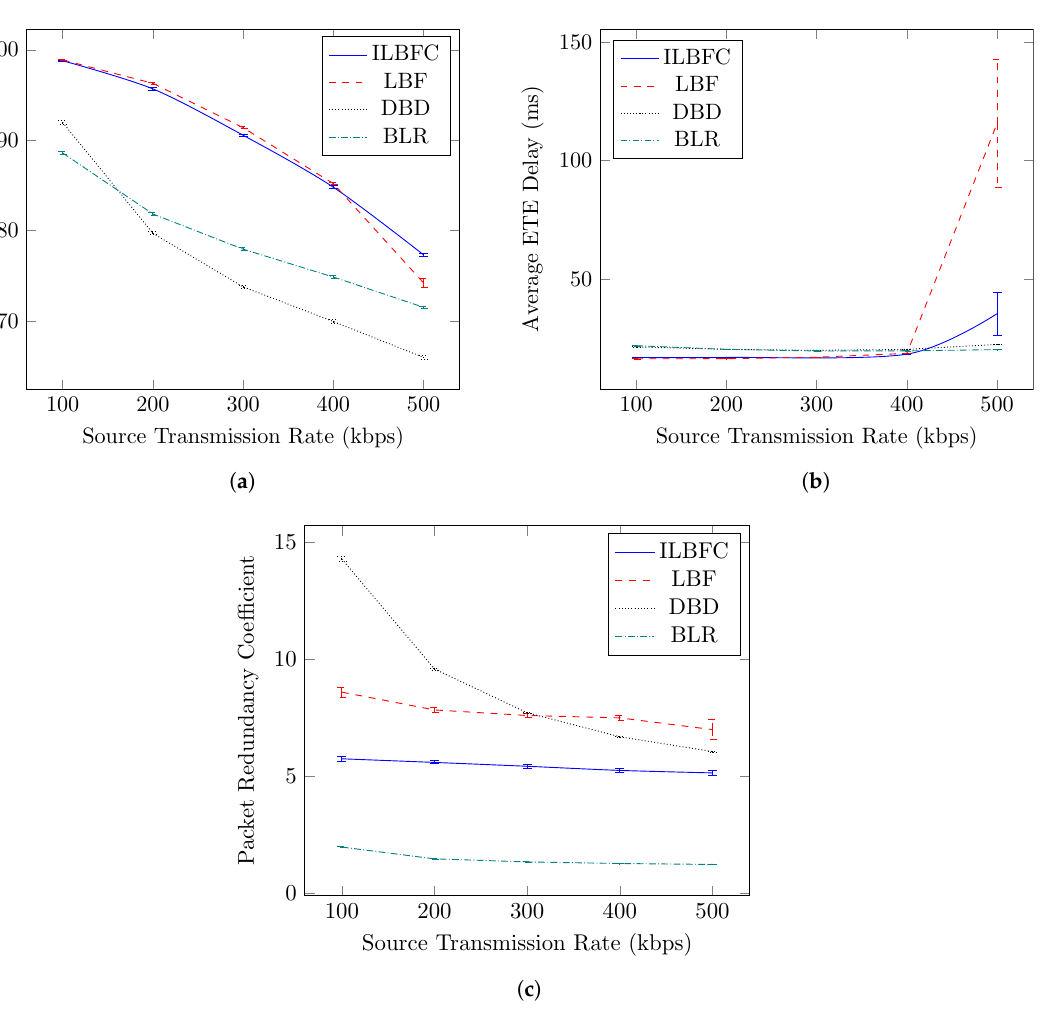
Figure 5. Performance comparison of ILBFC with LBF, DBD and BLR versus source transmission rate while keeping the maximum speed of the node equals 50 km/hr and the number of nodes equals 40. ( a ) PDR versus source transmission rate; ( b ) Average ETE delay versus source transmission rate; ( c ) PRC versus source transmission